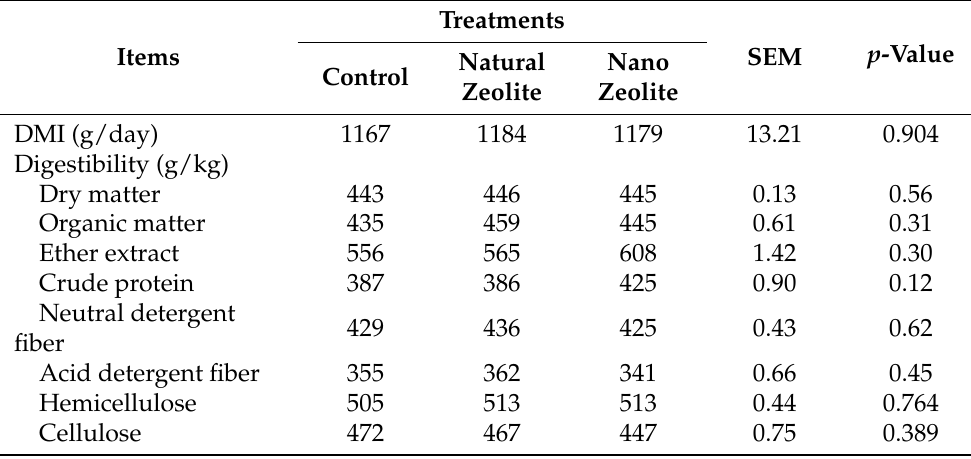
Table 7. Supplementation effects of natural or nano-zeolite on dry matter intake (DMI) and apparent nutrients digestibility of goats ( in vivo